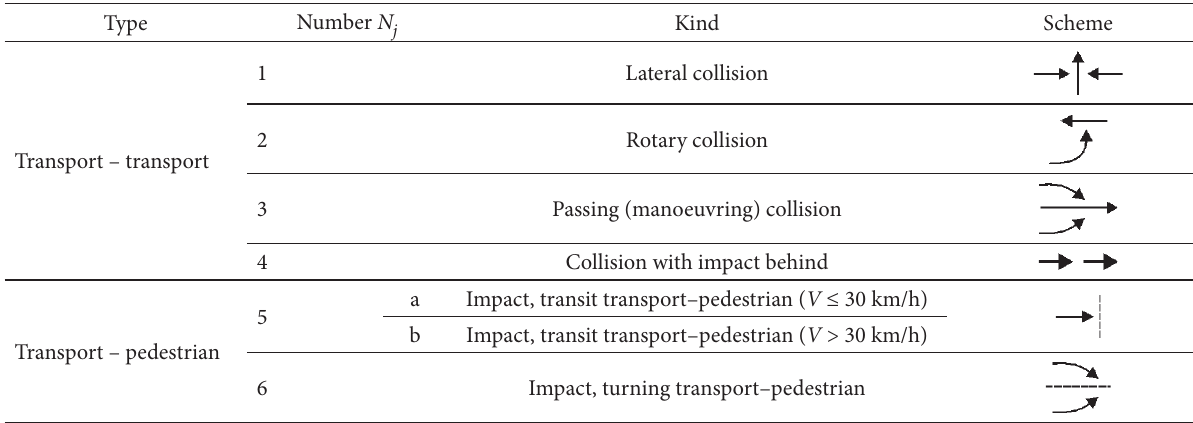
Table 3. The study sample of road